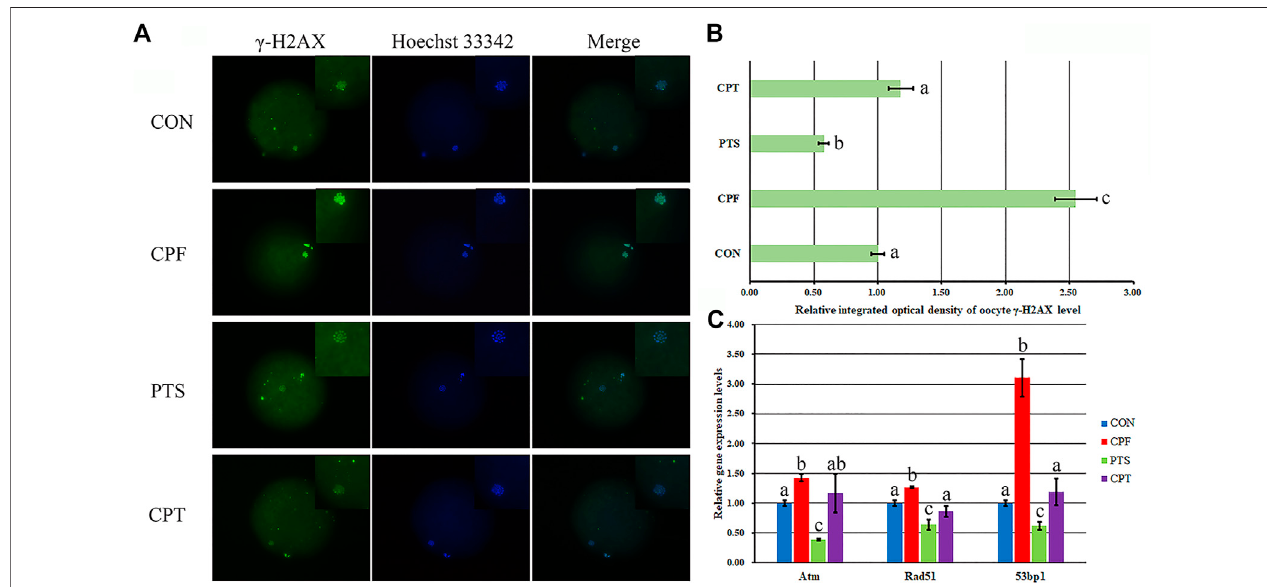
FIGURE 4 | Effect of CPF and PTS on oocyte DNA damage. (A) , fl uorescence of γ -H2AX ( × 400). (B) , relative integrated optical density of γ -H2AX. (C) , relative expression of DNA repair related genes. The number of oocytes for DNA damage detection in the CON, CPF, PTS or CPT group was 20, 19, 20 or 22, respectively. a-c Values for a certain group with different superscripts differ signi fi cantly ( p < 0.05).